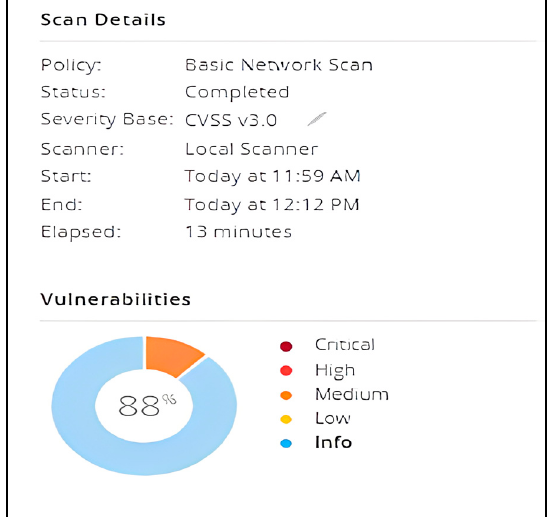
Figure 10. Results of scanning—Info.